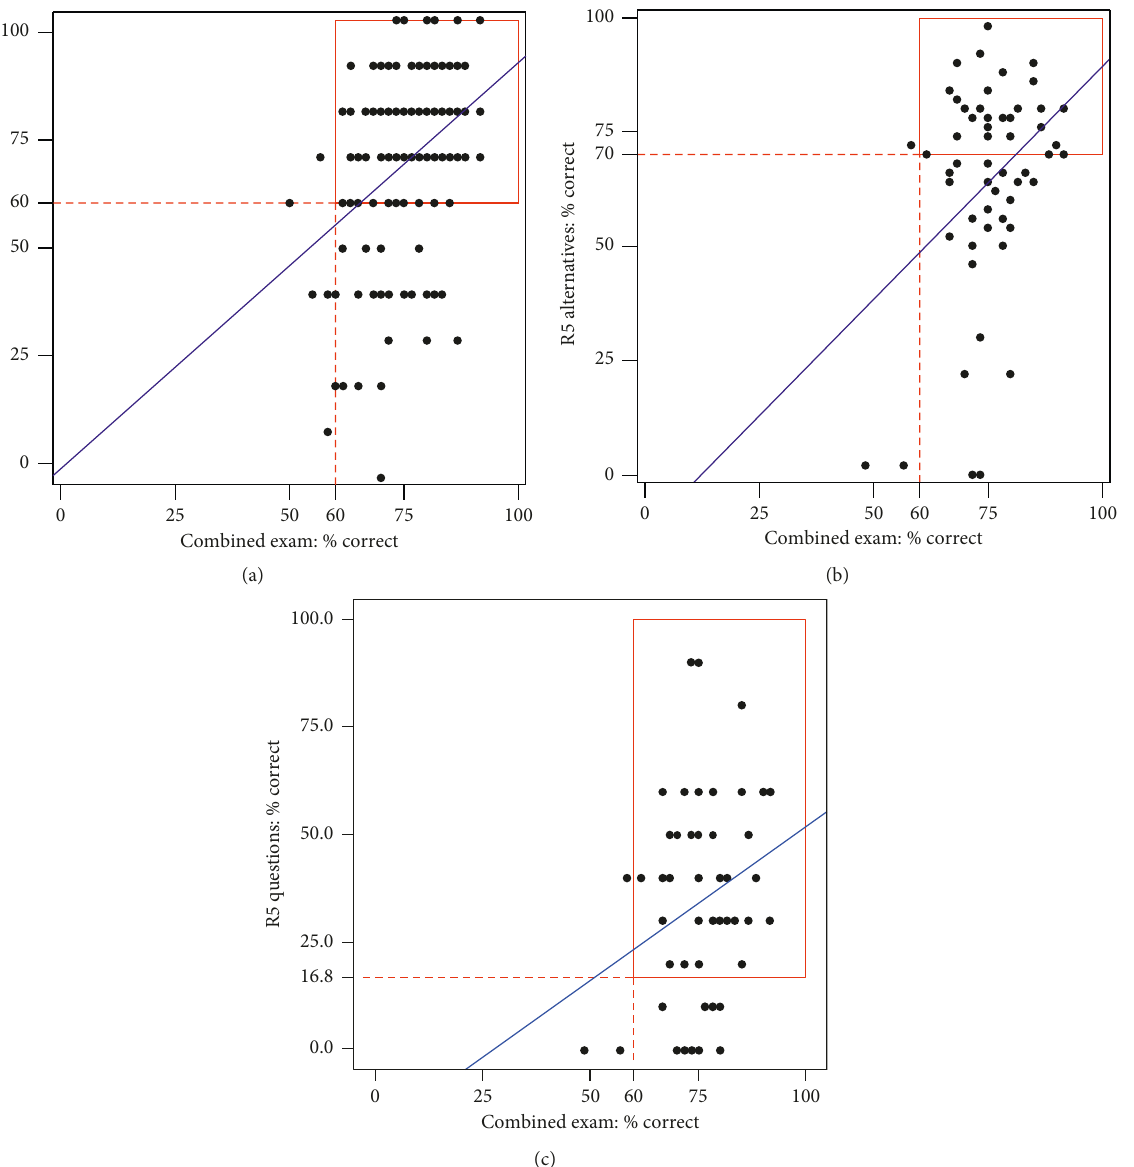
Figure 4: Performance of the year 2012 students. Performance of the 2012 SC group (panel (a)) and the R5 group when scoring alternatives (panel (b)) and whole questions (panel (c)) in the combined regular exams versus their performance in the additional questions. Each dot represents the scores of a single examinee with dots in the upper right rectangle being the ones that passed both exams. Dotted lines indicate scores required for passing. The straight line represents the linear fit to the